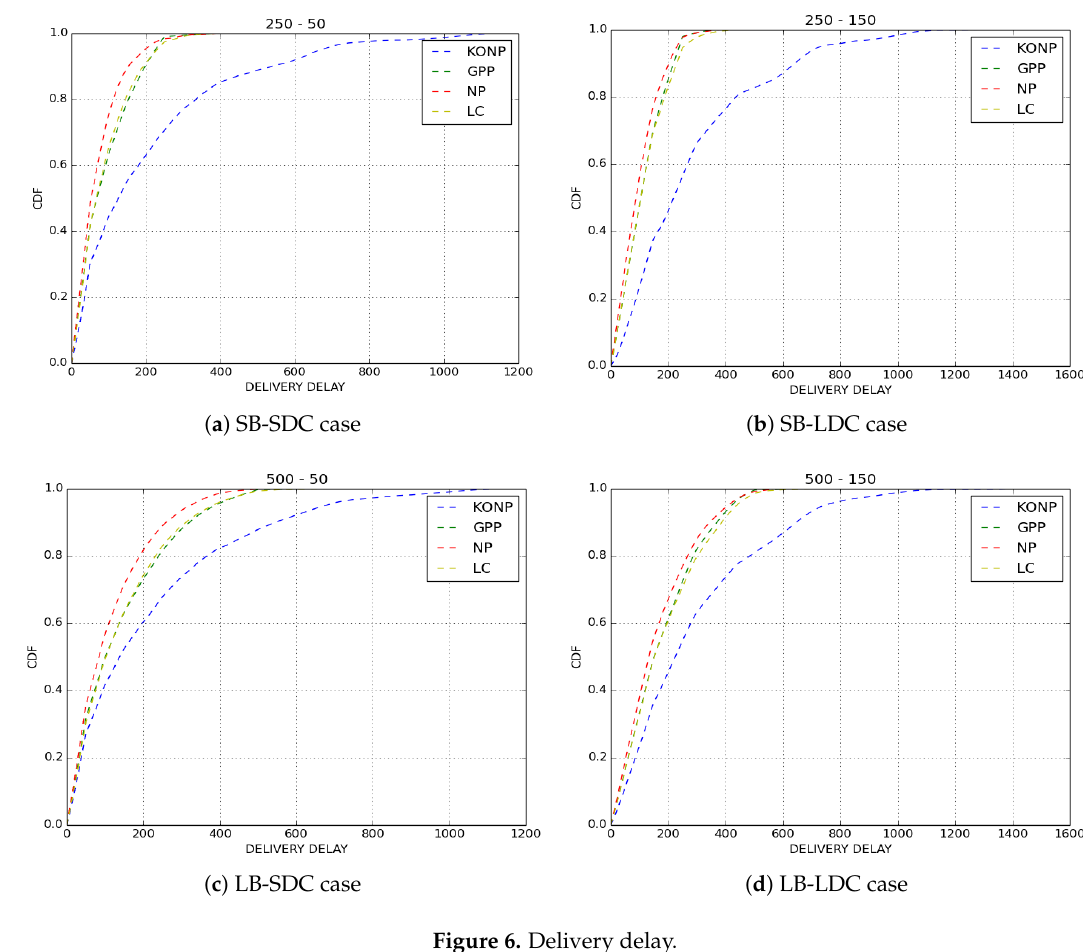
Figure 6. Delivery